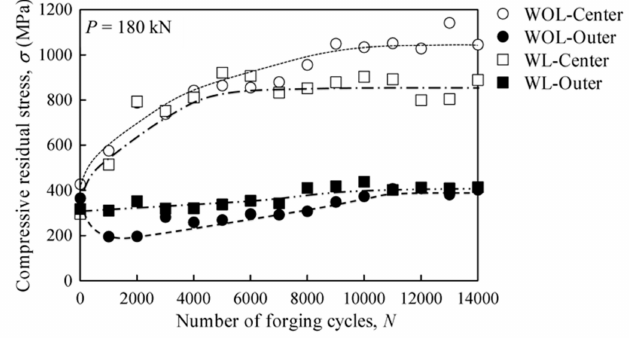
Figure 9. Compressive residual stress at the center and the average of outer areas by the number of forging cycles, for the 180 kN forging load. (WL—With Lubrication, WOL—Without